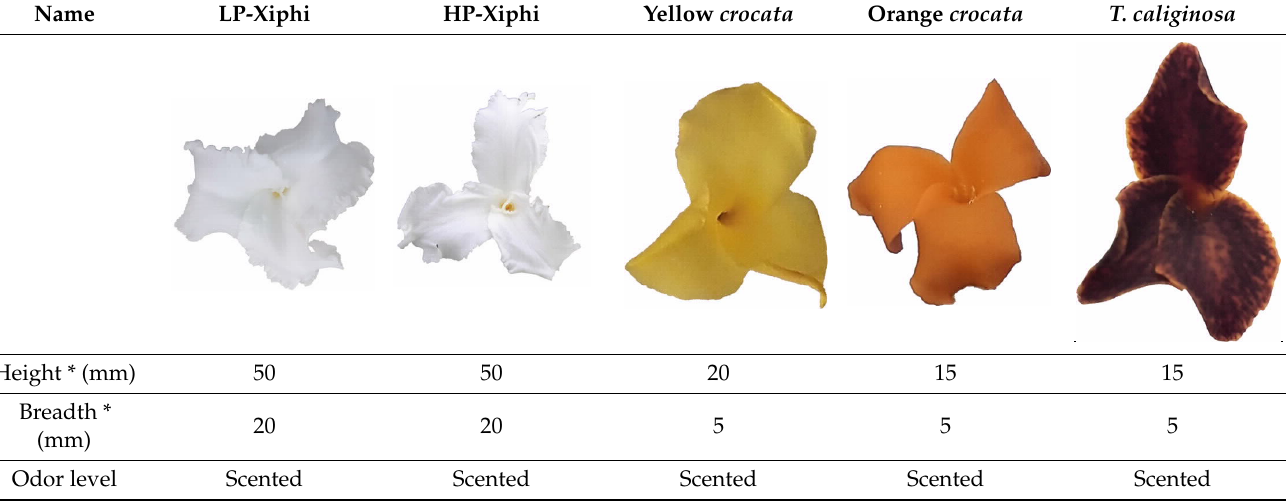
Table 1. Characteristics of the flowers of three species of the genus Tillandsia used in this study. Name